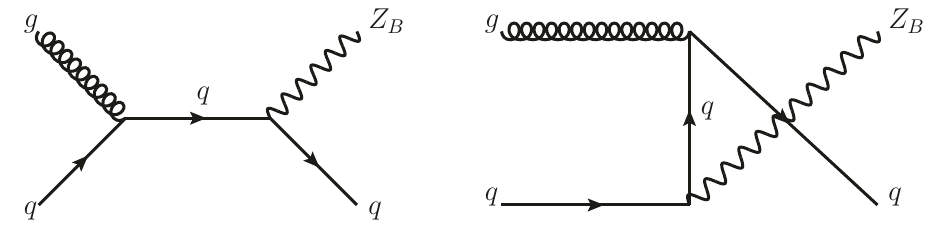
Figure 13 . Feyman graphs for gq